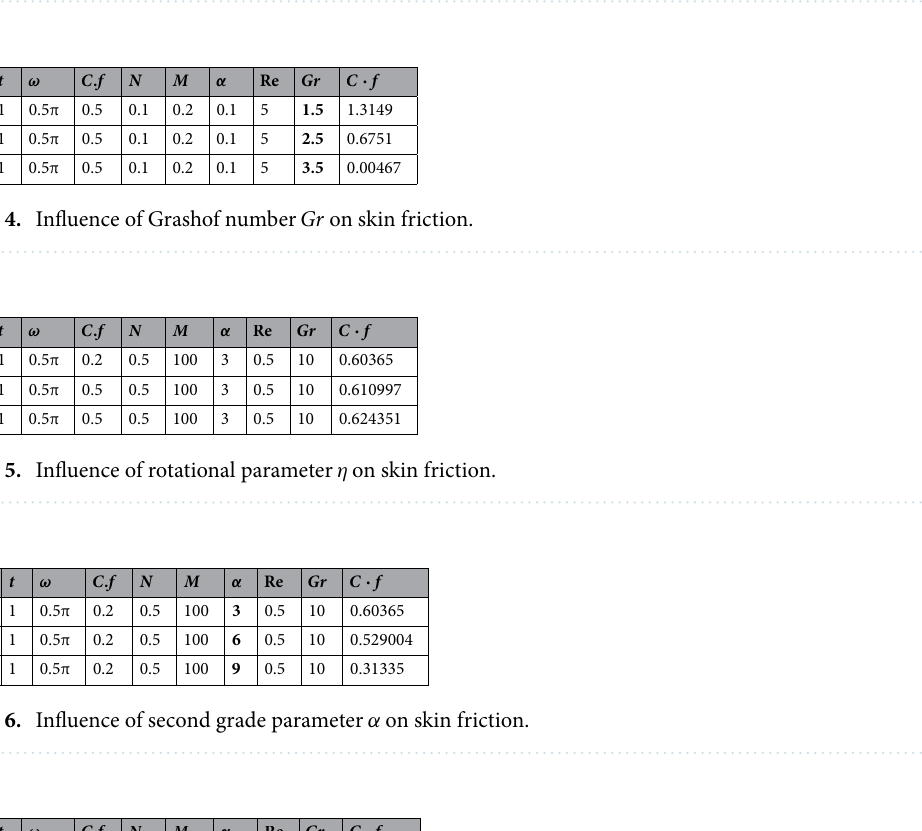
Table 3. Influence of dusty fluid parameter C . f on skin friction.